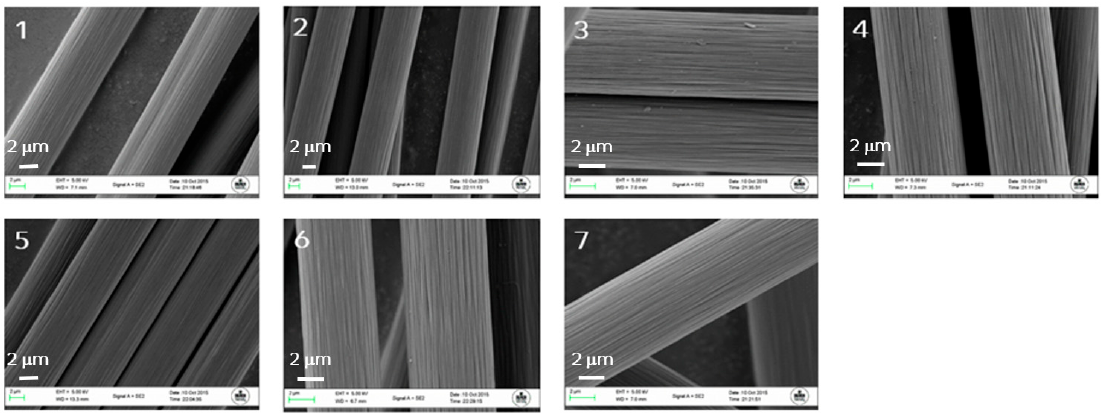
Figure 1. SEM images of all treated fibres from this study; sample 1 is the untreated sample, samples 2–7 show the same surface features and no surface defects have been detected.